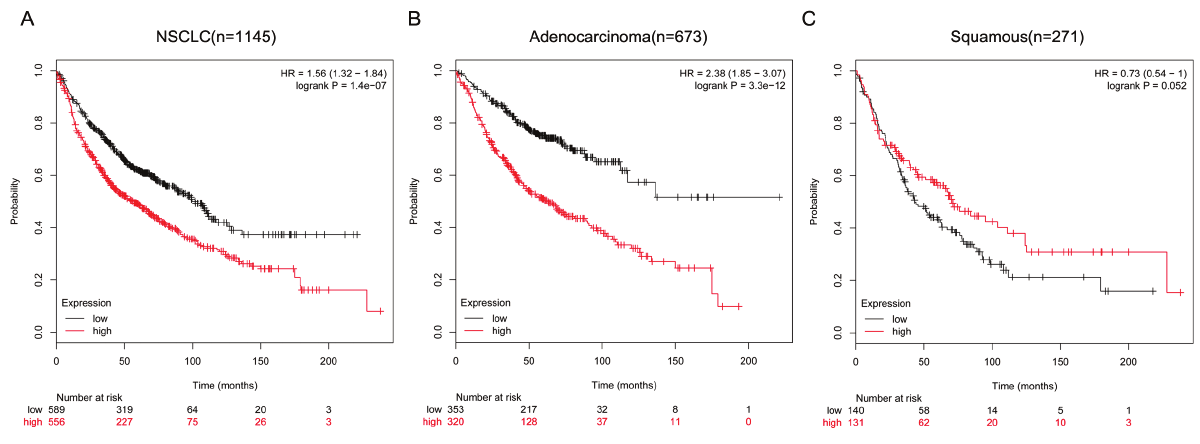
Figure 5: Relationship between CD276 expression level and prognosis of patients with NSCLC